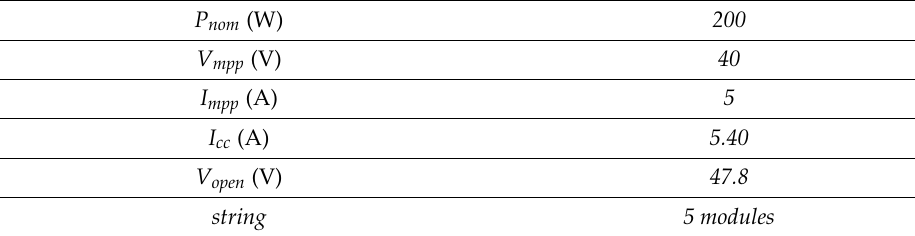
Table 6. PV modules (STC).